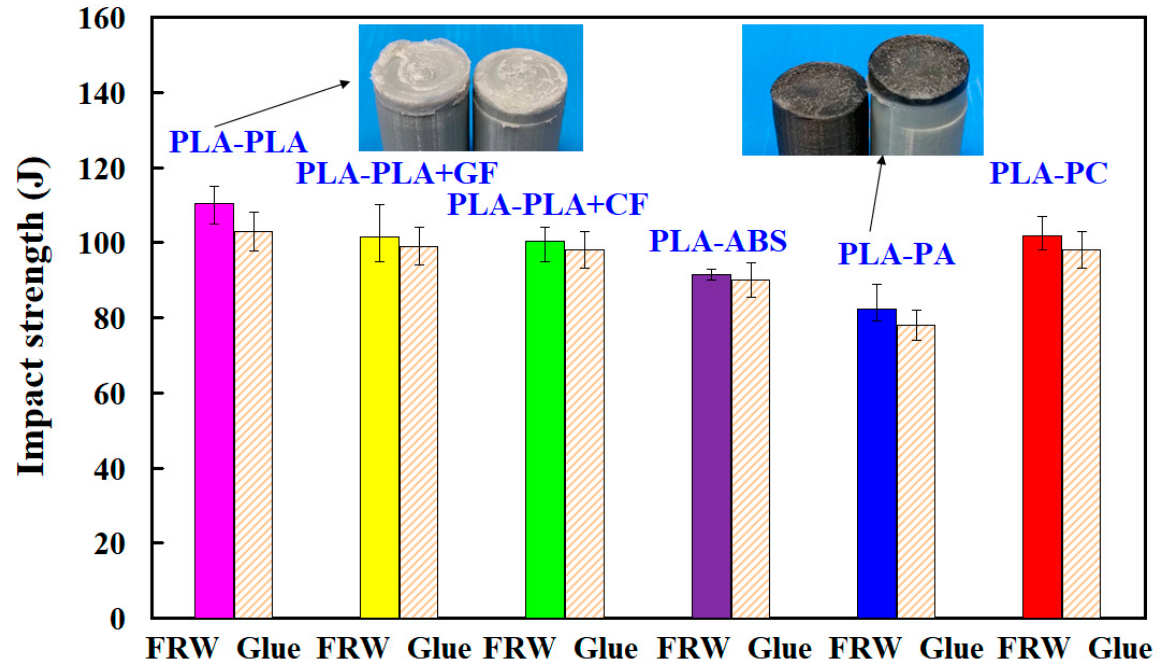
Figure 15. Impact strength of dissimilar polymer rods fabricated by FRW and gluing.